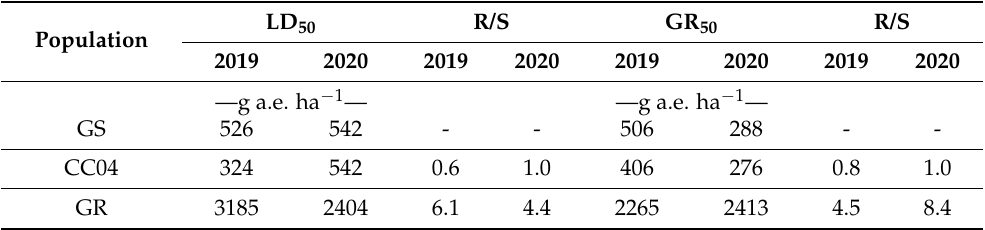
Table 2. Glyphosate dose required to kill 50% of plants (LD 50 ) or cause a 50% reduction in growth (GR 50 ), and the level of resistance compared to the susceptible population